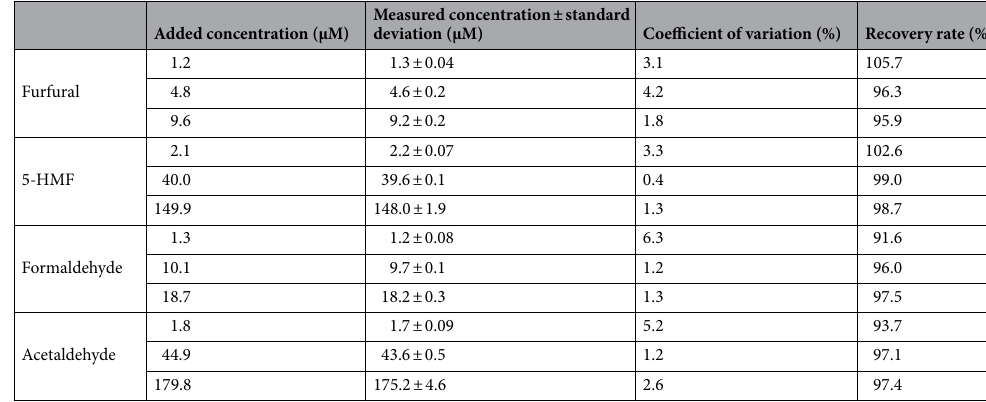
Table 2. Validation parameters of the UHPLC-DAD method for the quantification of monocarbonyls in glucose-containing PDFs after derivatization with DNPH (mean values ± standard deviation of six measurements).